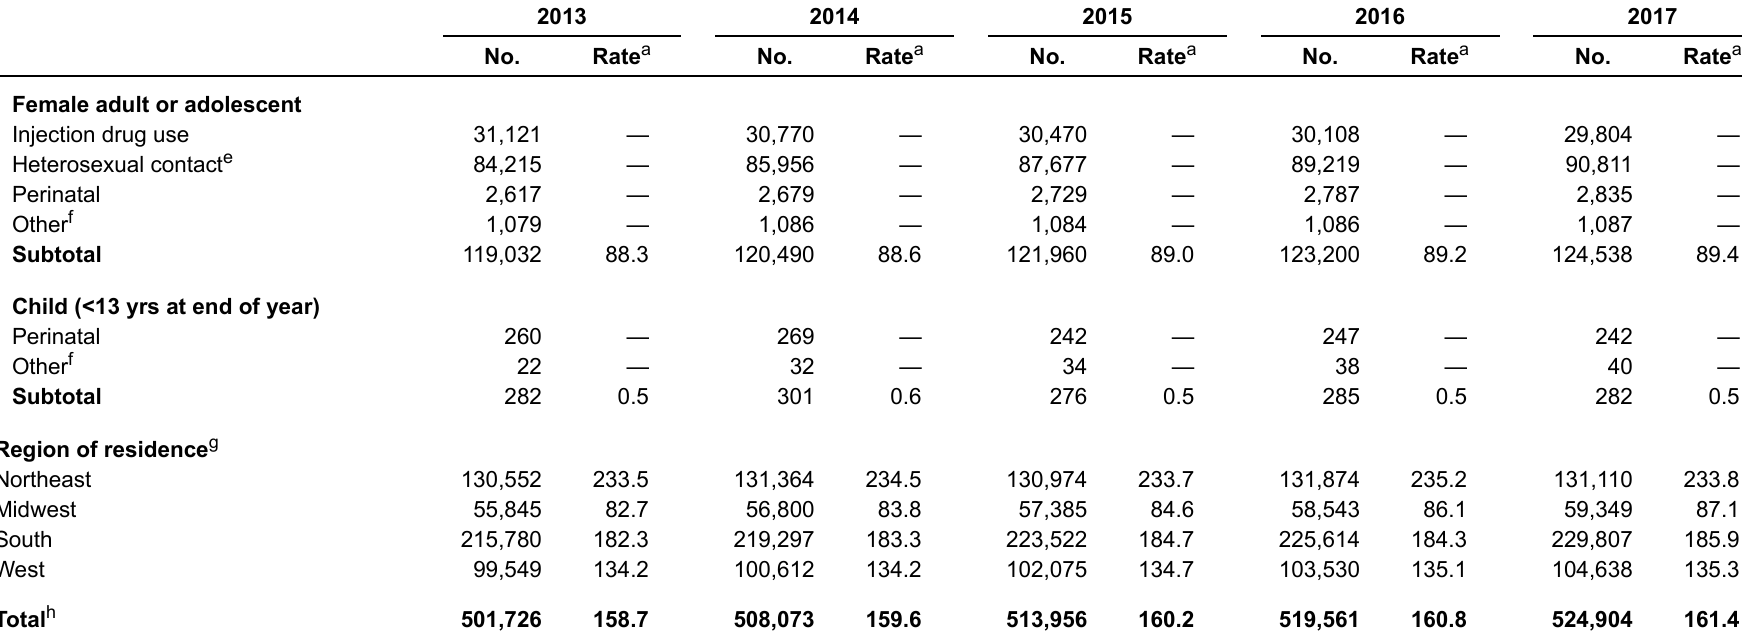
Table 23a. Persons living with diagnosed HIV infection ever classified as stage 3 (AIDS), by year and selected characteristics, 2013–2017—United States